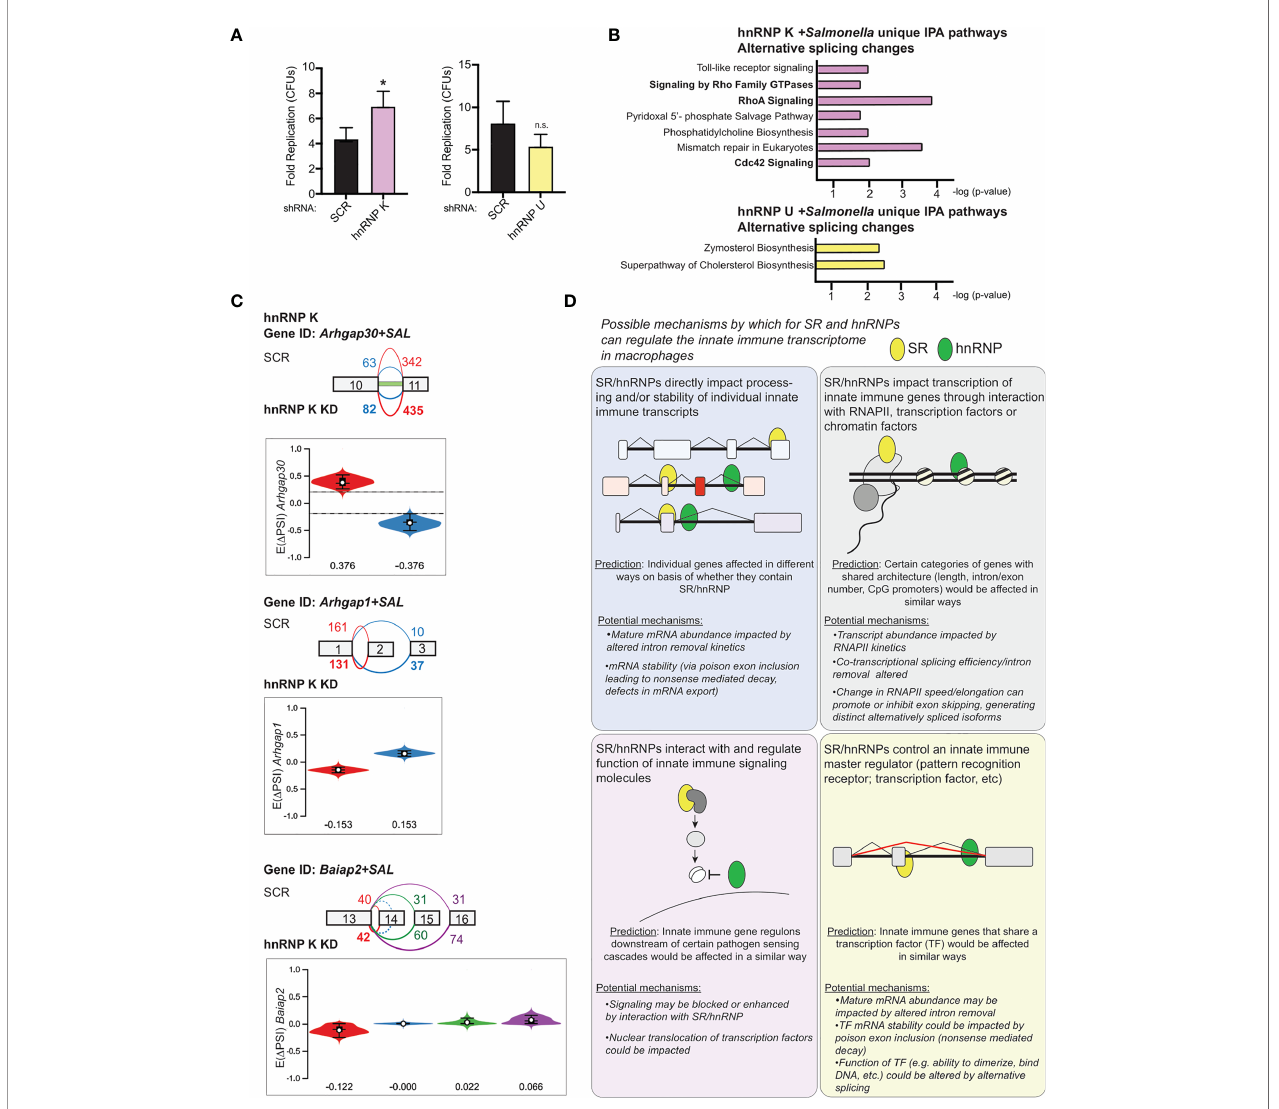
FIGURE 9 | hnRNP K regulates Salmonella replication and controls alternative splicing of genes involved in RhoA/Rac1-mediated reorganization of the actin cytoskeleton. (A) Colony forming units represented as fold replication (20h time point relative to 2h time point) in hnRNP K and hnRNP U knockdown RAW 264.7 macrophages infected with Salmonella Typhimurium (MOI = 10) (B) Ingenuity Pathway Analysis of hnRNP K (top) and hnRNP U (bottom) knockdown macrophages at 4h post- Salmonella infection. Pathways shown are unique to hnRNP K or hnRNP U cells and enrichment is shown as -log(p-value). (C) Local splicing variations identi fi ed in three genes related to Cdc42-mediated reorganization of the actin cytoskeleton: Arhgap30, Arhgap1, and Baiap2. Color of splicing events in the gene schematic corresponds to the colors in the violin plots (showing E D PSI). (D) Model of the potential mechanisms through which SR and hnRNP family members could impact innate immune gene expression in macrophages. For all RT-qPCRs values are the mean of 2 or 3 biological replicates and error bars indicate standard deviation.*p < 0.05; n.s. is not statistically signi fi